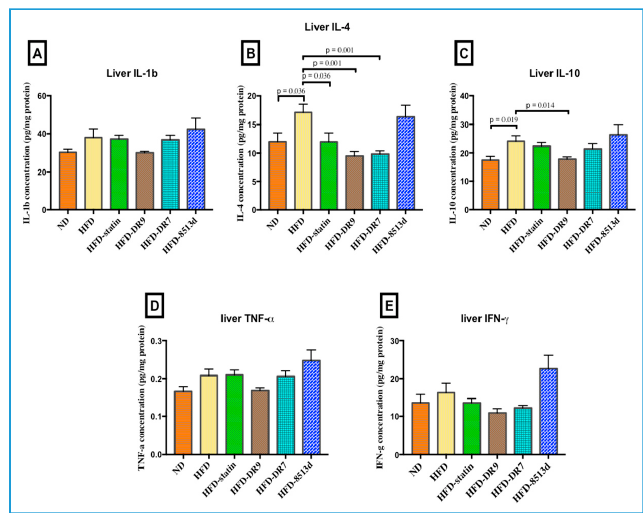
Figure 9. Cytokine levels of ( A ): Interleukin 1-beta (IL-1b), ( B ): Interleukin-4 (IL-4), ( C ): Interleukin-10 (IL-10), ( D ): Tumor necrosis factor-alpha (TNF- α ), ( E ): Interferon-gamma (IFN- γ )) in liver of D-galactose-induced aging rats (600 mg / kg / day) after 12 weeks of treatment. ND (normal diet), HFD (high-fat diet), HFD-statin (high-fat diet, receiving lovastatin 2 mg / kg / day), HFD-DR9 (high-fat diet, receiving L. fermentum DR9 (10 10 CFU / day), HFD-DR7 (high-fat diet, receiving L. plantarum DR7 (10 10 CFU / day), HFD-8513d (high-fat diet, receiving L. reuteri 8513d (10 10 CFU / day). Results are expressed as mean; error bars (SEM); n = 6. Statistical analysis was performed using independent t -tests.